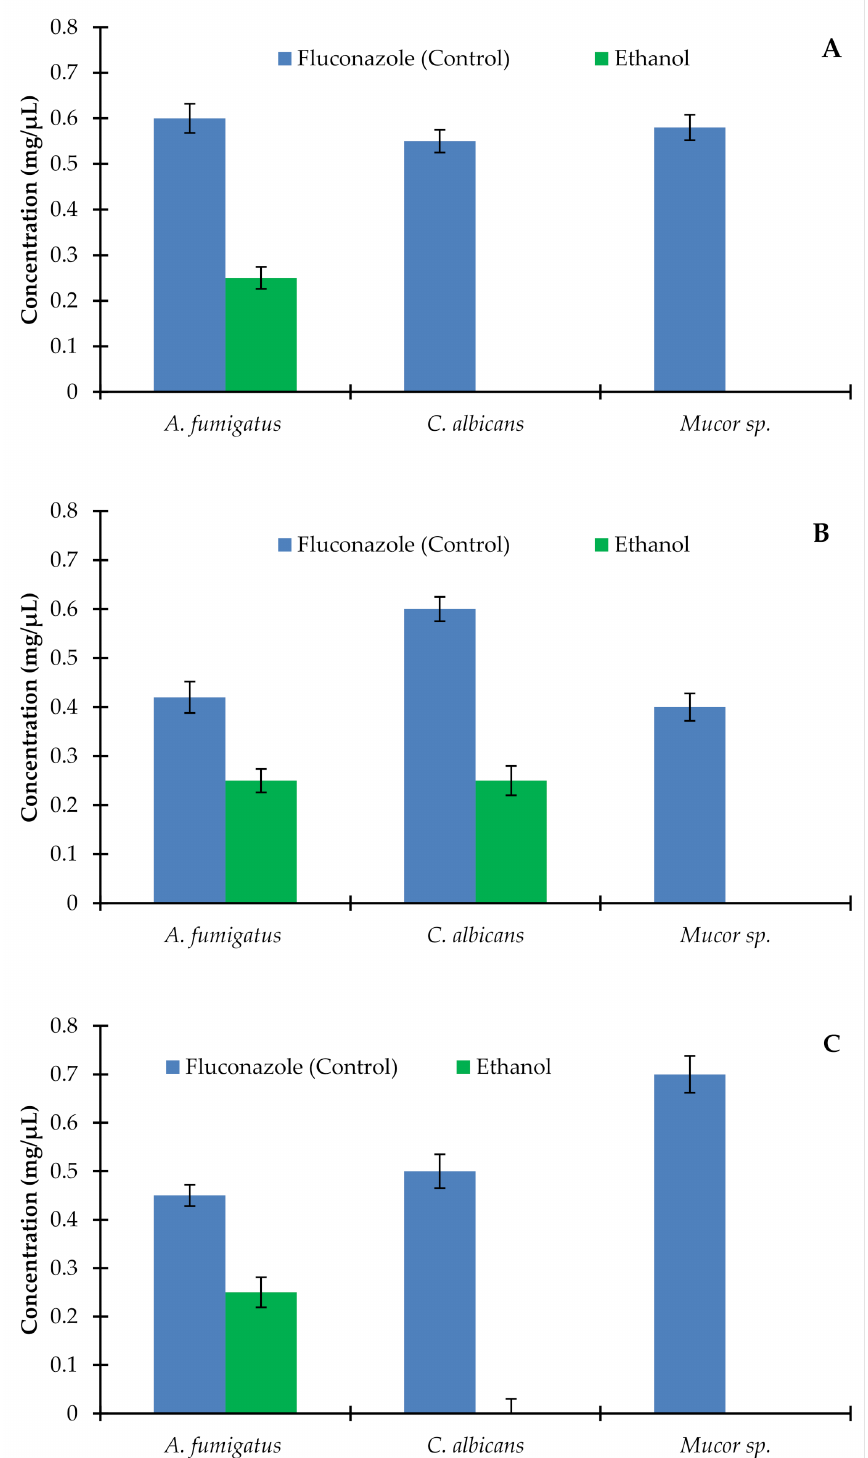
Figure 5. MIC values for the ethanolic extract of the root ( A ), fruits ( B ), and seeds ( C ) of Avicennia marina against Aspergillus fumigatus , Candida albicans, and Mucor sp. Fluconazole was used as the control. Ethyl acetate, petroleum ether, chloroform, and aqueous extracts of root, fruit, and seeds of Avicennia marina did not show any inhibitory effects on the tested fungal strains. Only ethanol extract showed an inhibitory effect on A. fumigatus and C. albicans. Values are the mean of five replicates ( n = 5). Vertical bars show standard